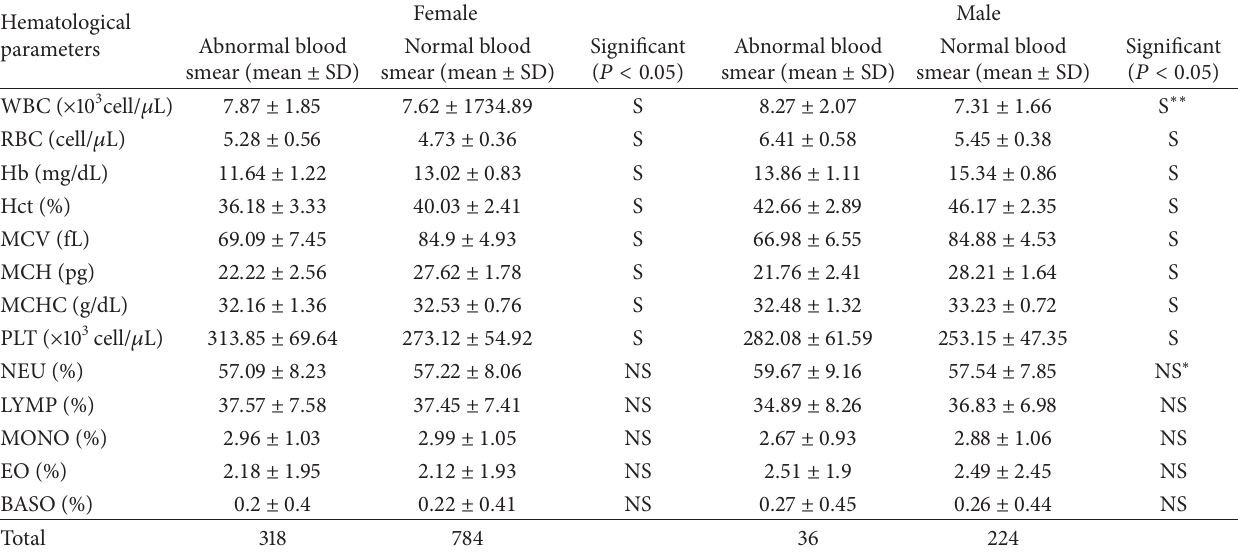
Table 2: The hematological parameters which were categorized by RBC morphology and sex. Hematological